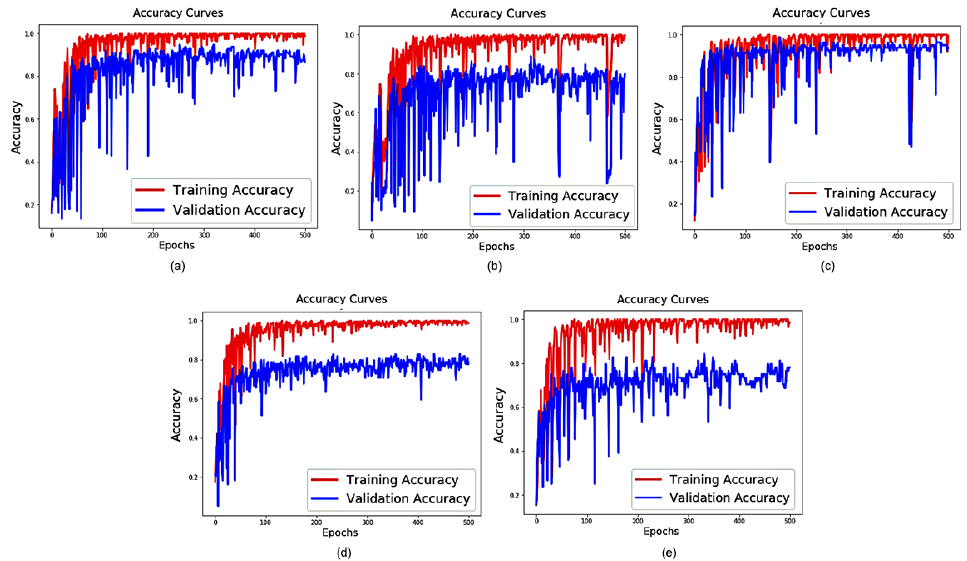
Figure 11. Accuracy curves of multicultural groups namely ( a ) Moroccans; ( b ) Caucasians; ( c ) Taiwanese; ( d ) Americans; and ( e ) Japanese for seven emotions with Deep Convolutional Neural Network Facial Expression